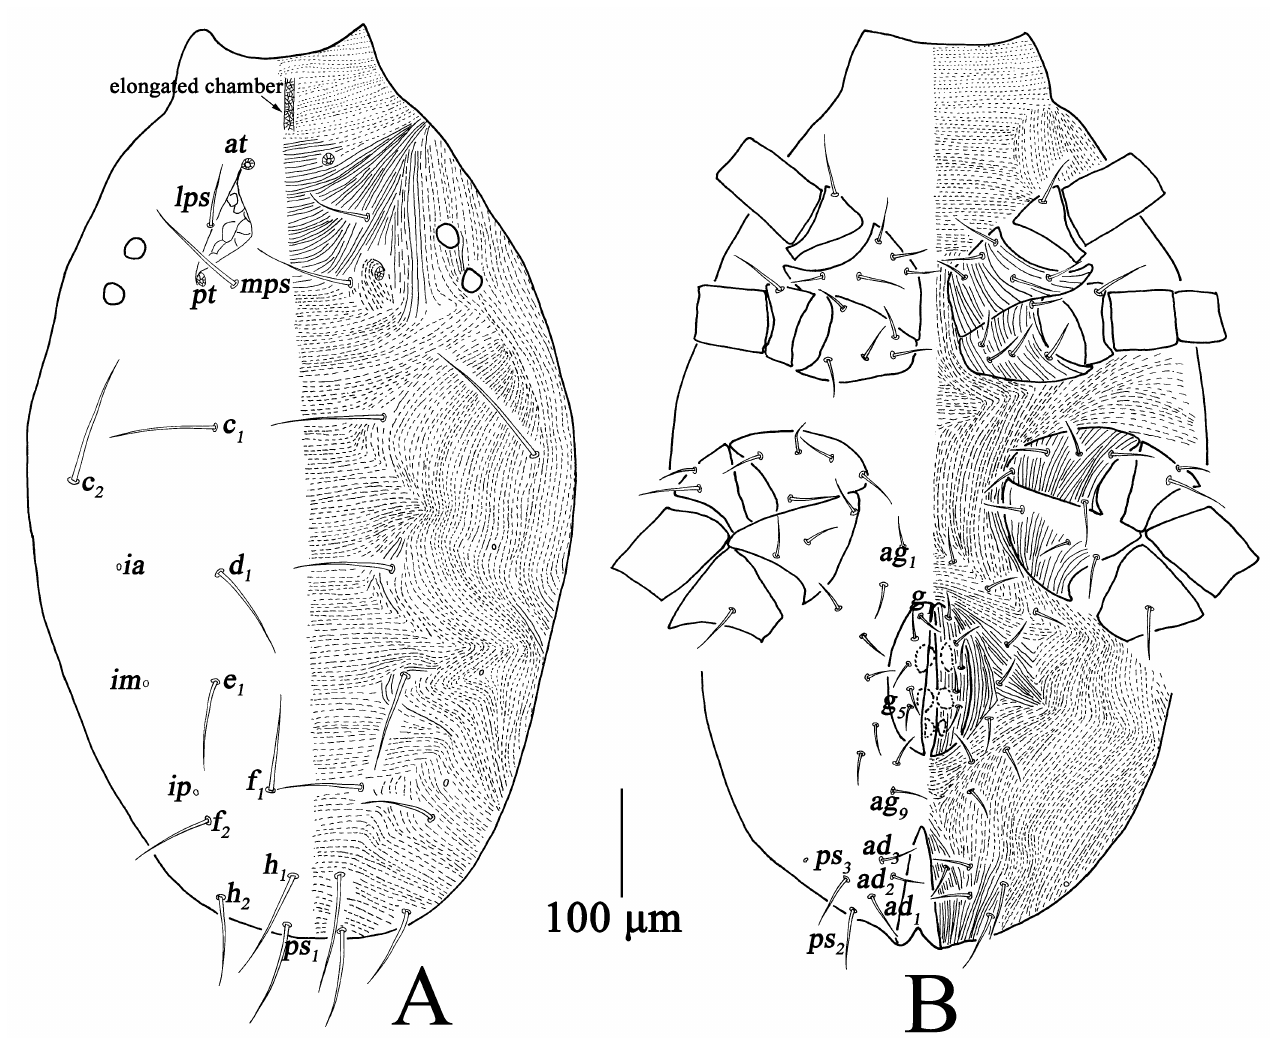
Figure 5. Bdella muscorum , tritonymph: ( A ) Dorsal view of idiosoma; ( B ) Ventral view of idiosoma.